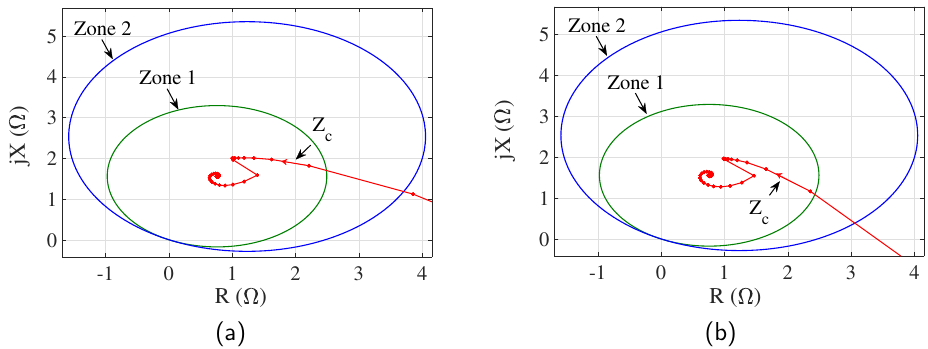
Figure 18. Impedance trajectory for ( a ) 3LG and ( b ) SLG faults at 40% of the feeder’s